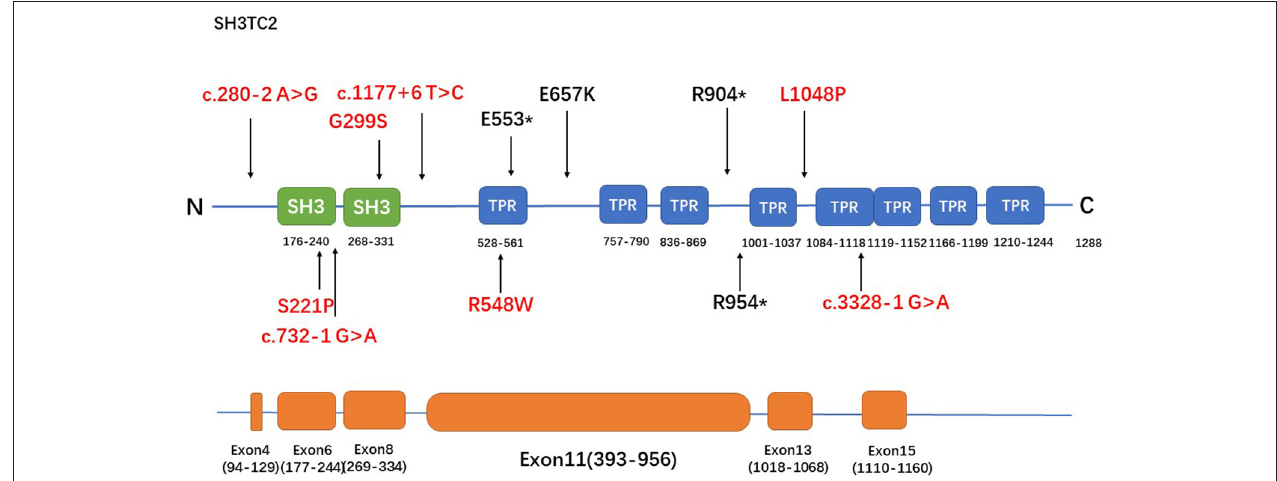
FIGURE 2 | The spectrum of SH3TC2 mutations identified in this study. The upper panel is the SH3TC2 protein structure (Uniprot: Q8TF17) and the bottom panel shows the SH3TC2 gene sequence, showing exons associated with identified mutations. Five of the 12 mutations lie in exon 11, and the remaining mutations are scattered along the whole gene. Novel mutations were labeled in